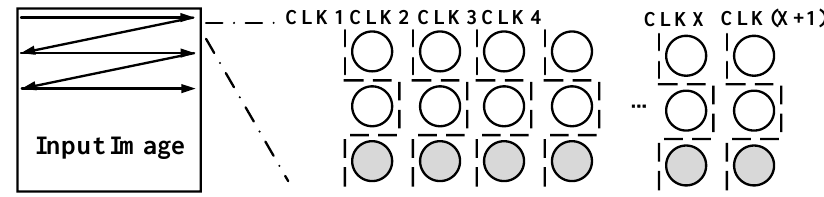
Figure 2. Scanning method for S = 1.